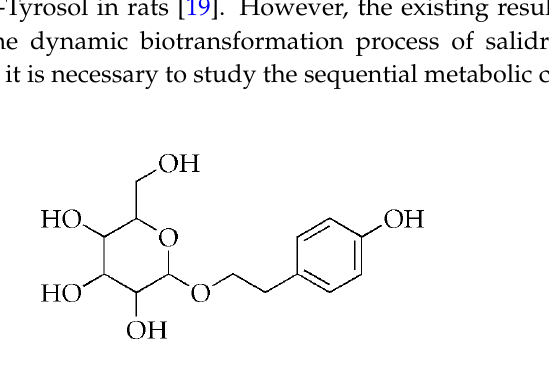
Figure 1. Chemical structure of salidroside.